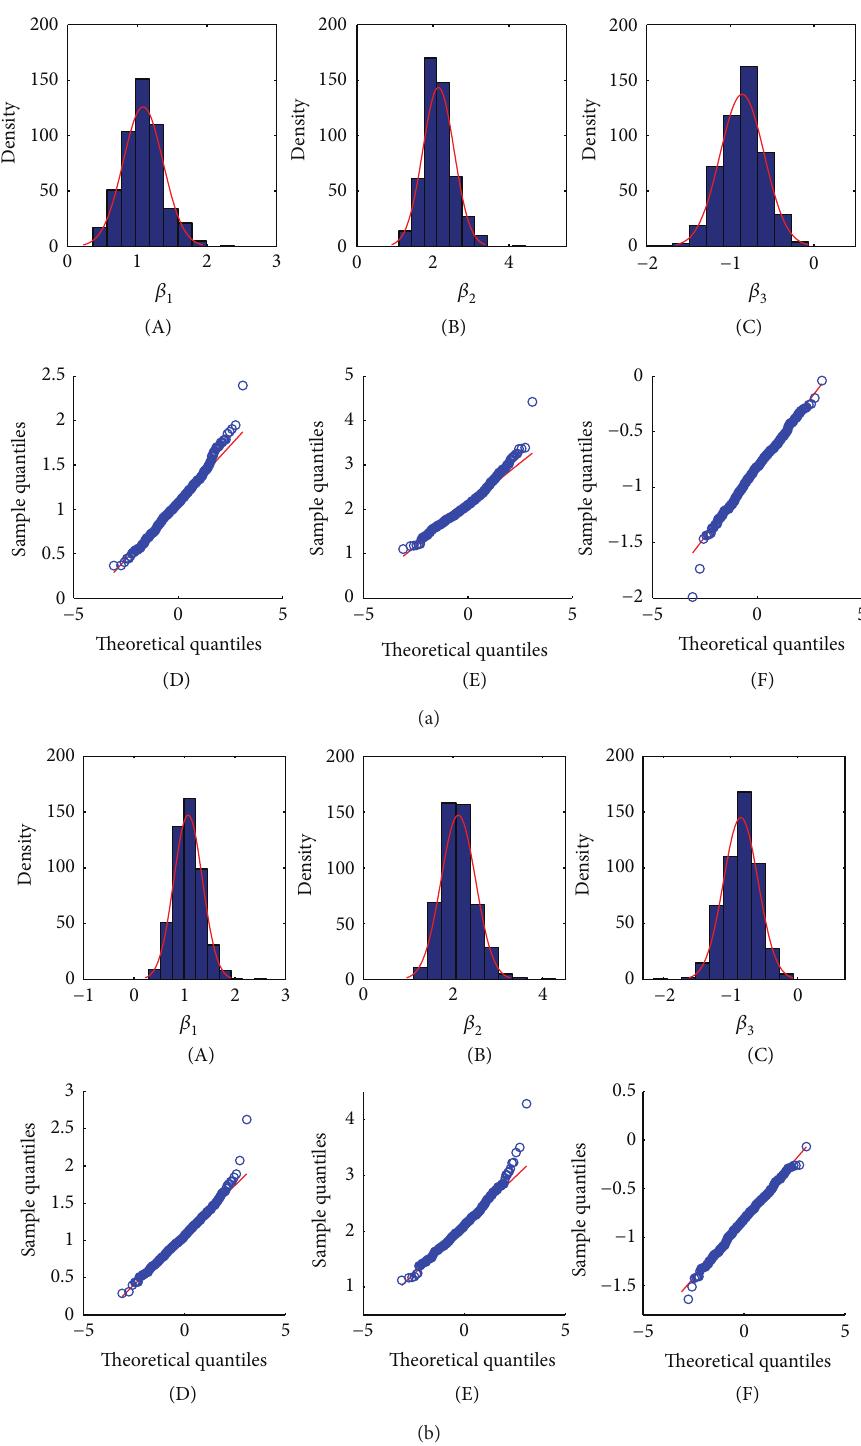
Figure 2: The histograms and the QQ plots for the maximum empirical exponential tilting estimators based on the empirical exponential tilting method for 𝑛 = 60 . When the true correlation structure is AR(1), the left plots are obtained by using the misspecified CS working correlation structure and the right plots are obtained by using the true AR(1) working correlation